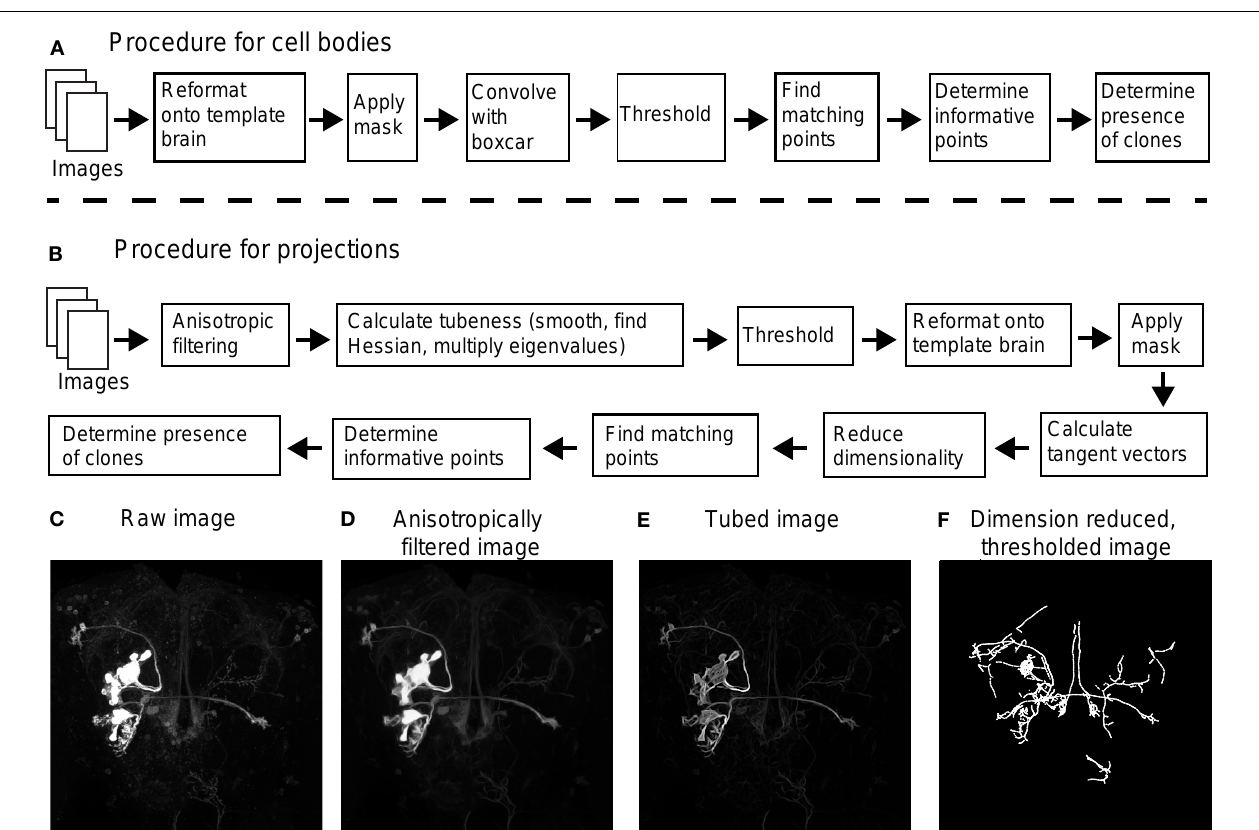
FIGURE 1 | Flowchart describing the different steps of the procedure (see Materials and Methods). (A) To process cell body information, images were first reformatted onto the common template brain and were then masked to eliminate any contribution from the neuropil. Images were then isotropically filtered, thresholded and those points above threshold were compared between images based on coordinate position alone.We then calculated how informative the presence of each point was of each clone, and used these values to identify clones in novel images. (B) To process neural projection